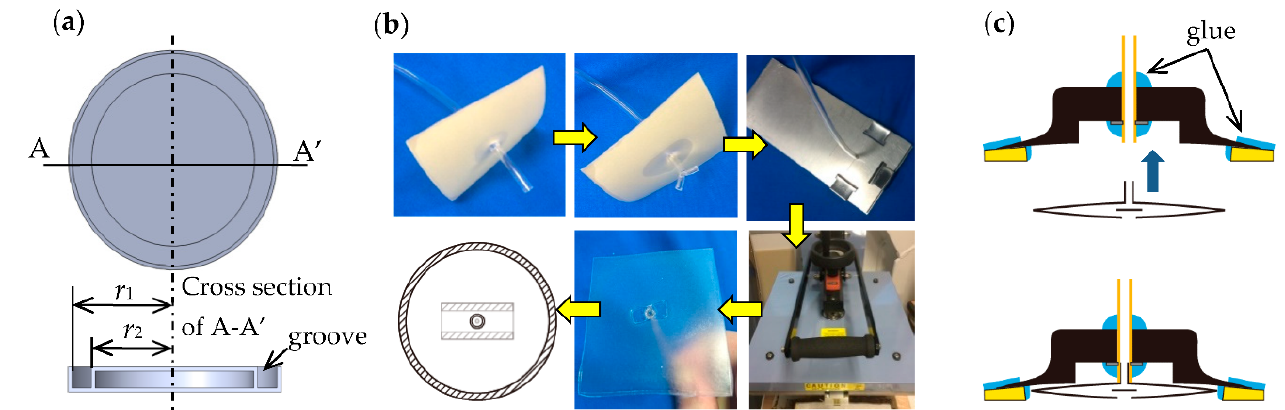
Figure 3. Fabrication process: ( a ) supporting force in the perpendicular and shearing determined by the sticky force of the gel ring and the suction force; ( b ) cross-sectional view of the release balloon in the unpressurized state; ( c ) combination of the gel ring and a release balloon to a holder.